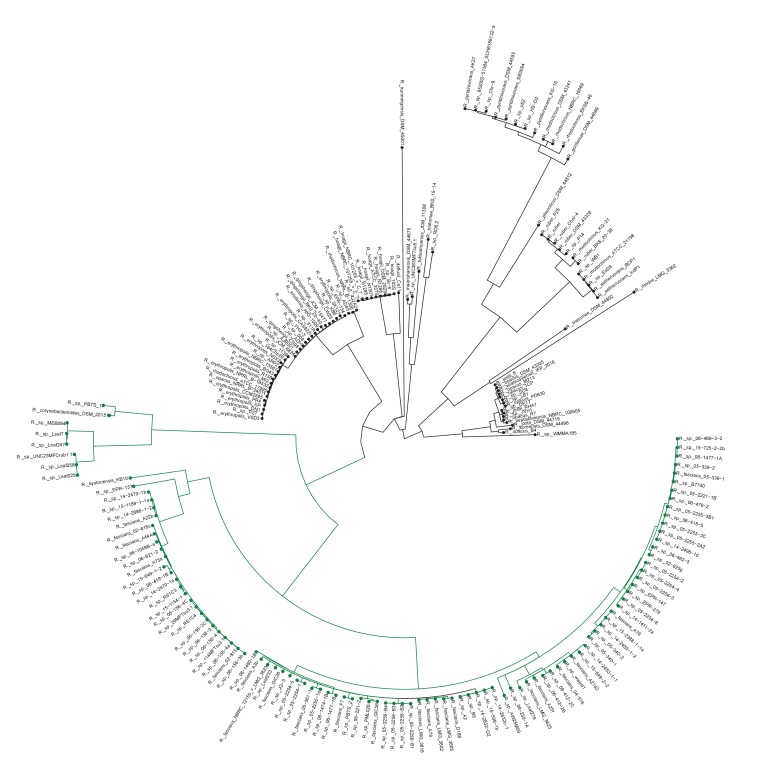
Plant-associated Rhodococcus form a distinct clade.Multi-locus sequence analysis maximum likelihood tree of isolates of the Rhodococcus genus. Translated sequences for ftsY, infB, rpoB, rsmA, secY, tsaD, and ychF from 199 members of Rhodococcus were identified using TBLASTN, aligned, and used to generate a multi-locus maximum likelihood tree.